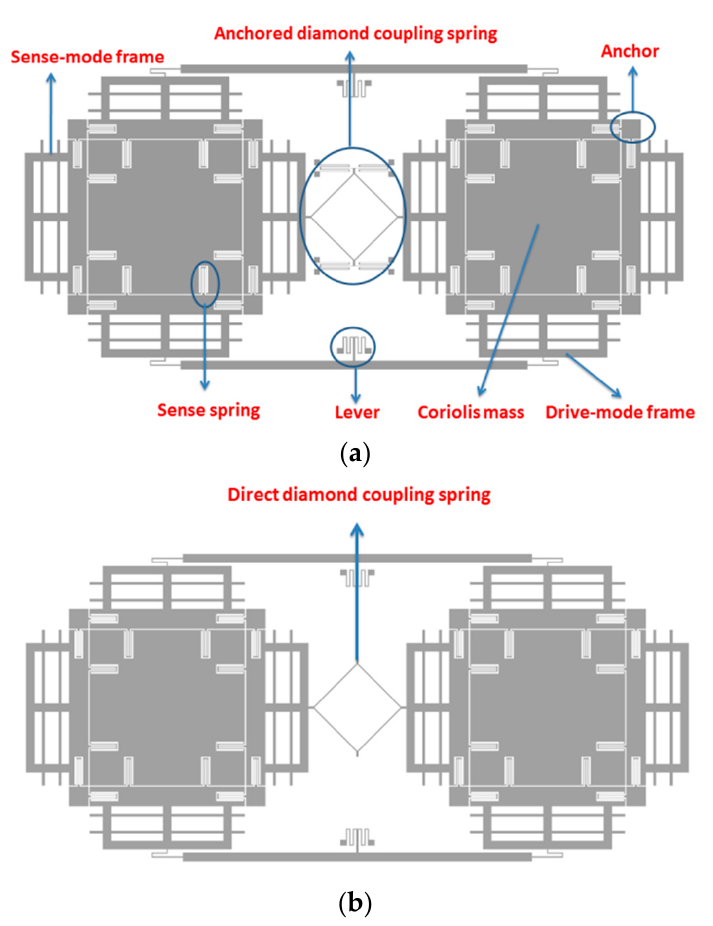
Figure 1. Schematic of the designed TFGs ( a ) Type A ( b ) Type B.